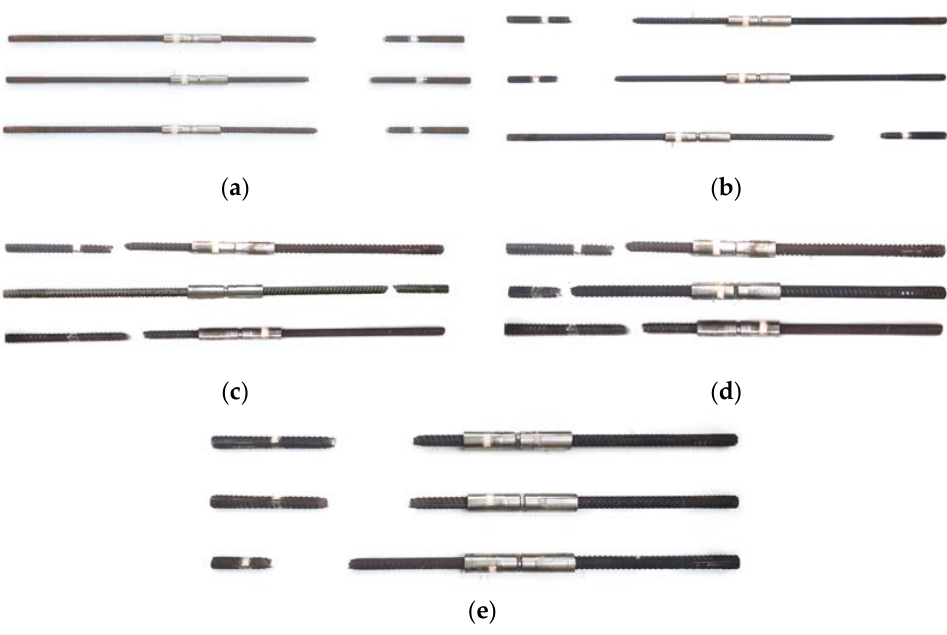
Figure 4. The failure mode of the specimen after the dynamic tensile test. ( a ) Φ16 ; ( b ) Φ20 ; ( c ) Φ25 ; ( d ) Φ32 ; ( e ) Φ40. Table 4. Analysis table of failure mode of test